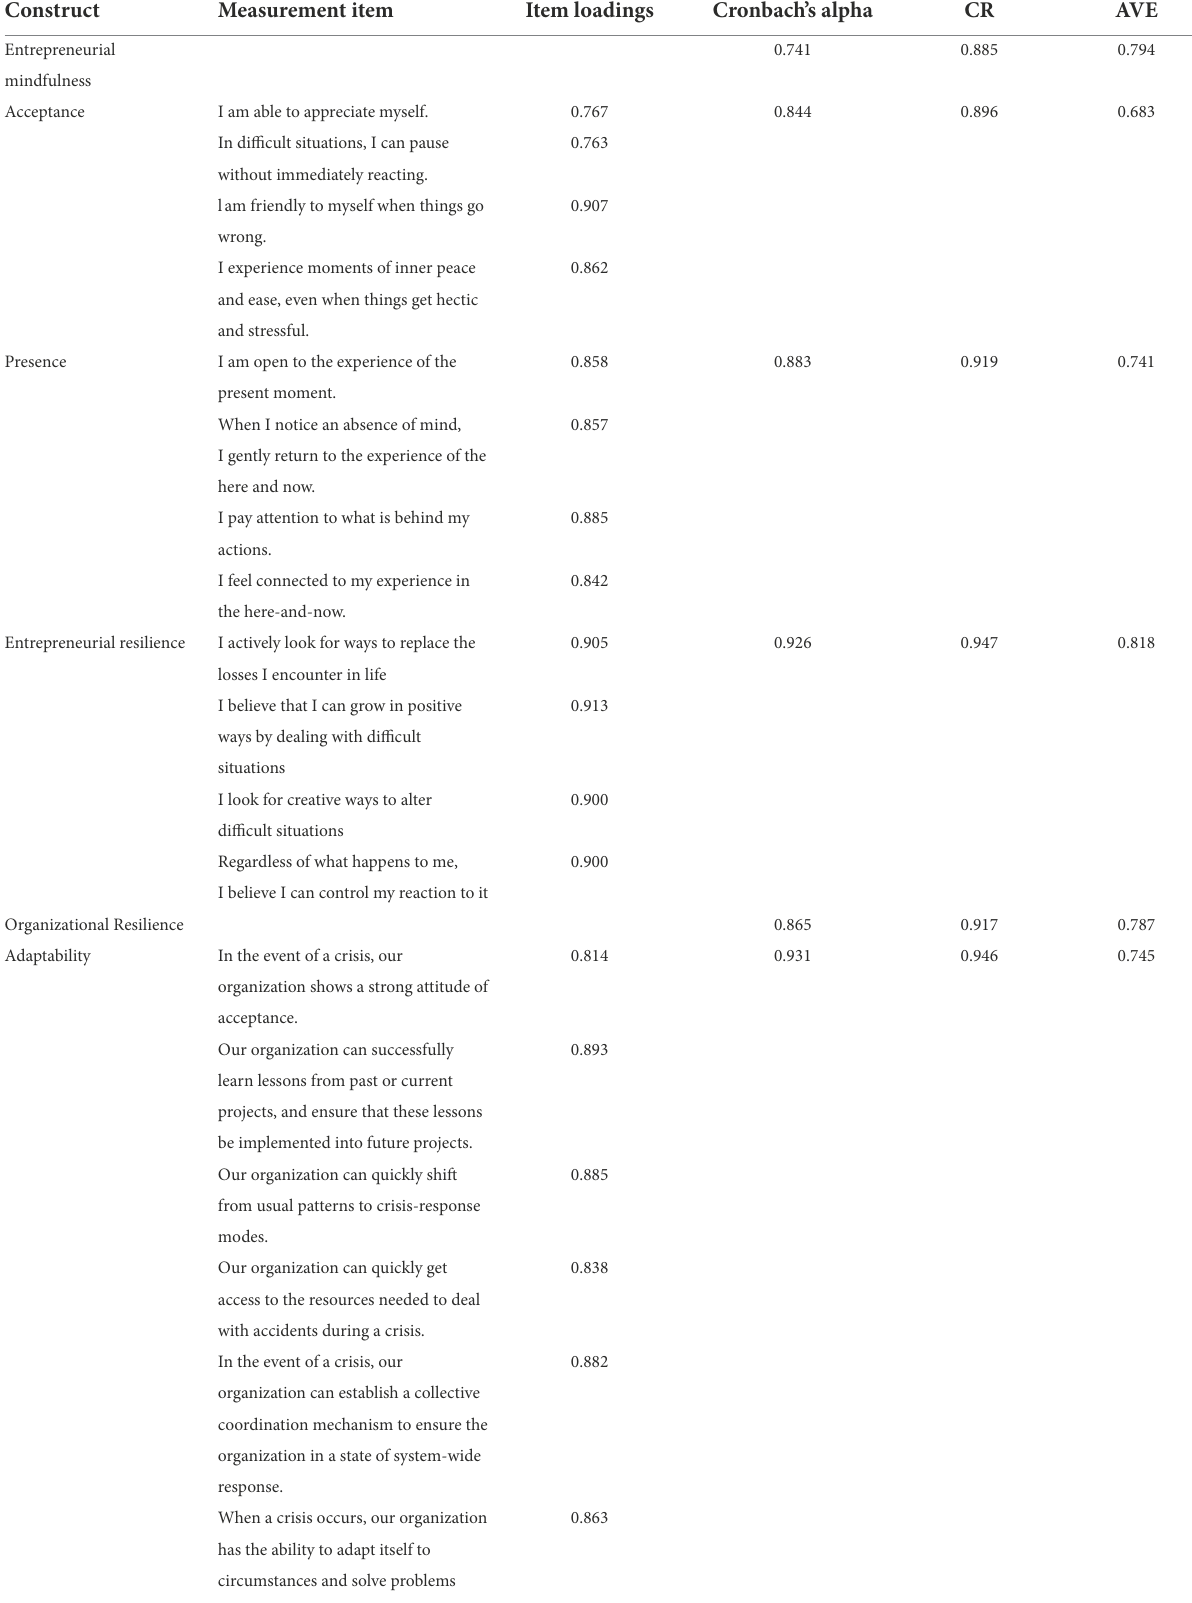
TABLE 3 Quality criteria of reflective first-order-constructs.